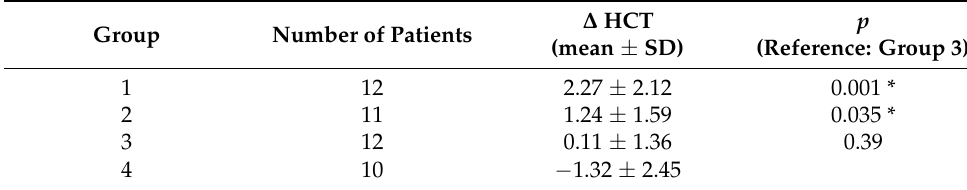
Table 2. Patients grouped according to the number of poor erythropoietic response factors associated with erythropoietic response.